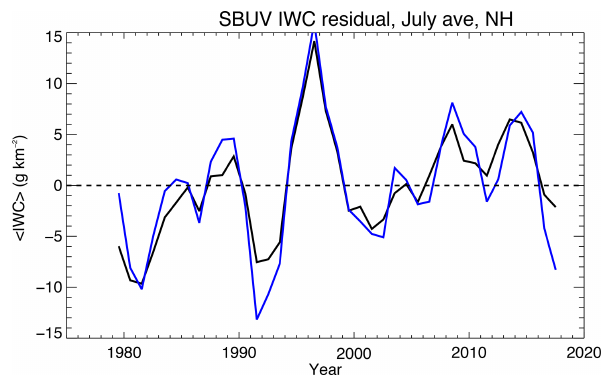
Figure 12. Comparison of annually-averaged Northern Hemisphere July-averaged residuals ( (cid:104) IWC (cid:105) long-term mean) derived by two in- dependent methods from SBUV 273nm albedo data. Black curve: (cid:104) IWC (cid:105) derived from the AIR approximation. Blue curve: (cid:104) IWC (cid:105) de- rived from the same SBUV albedo data but including mean particle size variations (see text). 3-year smoothing has also been